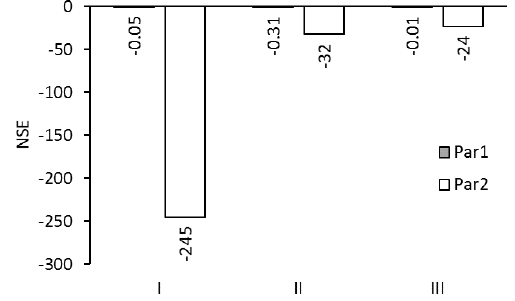
Figure 10. NSE for reverse solute fluxes of test series A5 simulated with Models I, II, and III using membrane parameter sets Par1 and Par2.